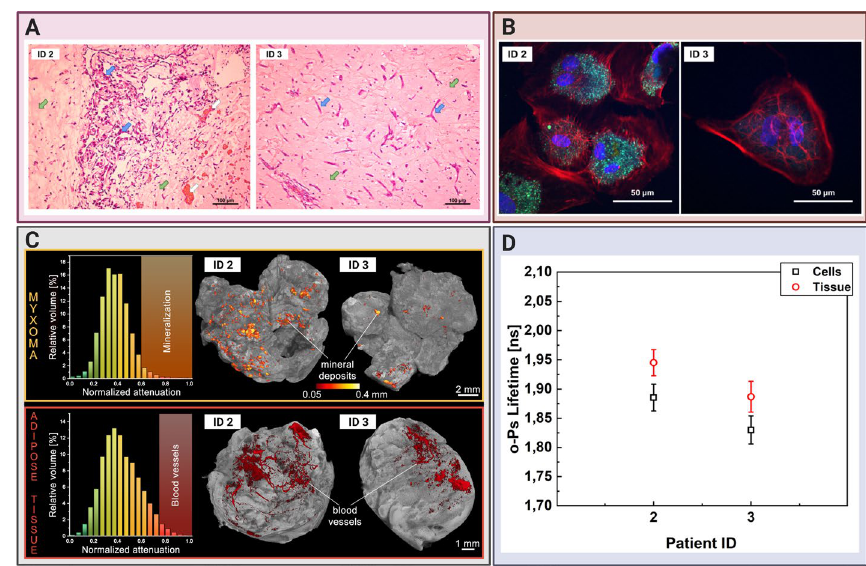
Fig. 5 Comparing cardiac myxoma (CM) tissues and the isolated cell line. a Micrograph showing exemplary histopathology findings of cardiac myxoma (CM), for patient ID 2 and ID 3 in H&E staining. CM cells stained in purple (blue arrow) can have stellate (ID 3) or globular (ID 2) shape. The red/orange structures (white arrow) correspond to the blood vessels with erythrocytes. The surrounding myxoid matrix is stained in pink (green arrow). b Confocal microscopy image with the CM cells stained for F-Actin (red), nucleus (blue), and VE-cadherin (green). The scale bar is 50 μm. c Micro-computed tomography results for CM (upper row) and adipose tissues (lower row). Histograms on the left side present normalized X-ray attenuation within the sample: (i) the mineral deposits range from 0.6 to 1.0 in the CM samples; (ii) the blood vessels range from 0.75 to 1.0 in the adipose tissue samples. These attenuation ranges have been binarized to extract the mineral deposits and blood vessels for further analysis and visualization. The right side contains volume-rendered 3-D models of the two most representative samples, namely CM and adipose tissues. The internal mineral deposits have been highlighted in the CM model. Its diameter has been color-coded using a heat map. The blood vessels have been colored red in the adipose tissue. d Results of the mean ortho-Positronium (o-Ps) lifetime for CM tissue (red circles), isolated from the same patient myxoma cell line (black squares). Patients ID annotations are described in Table